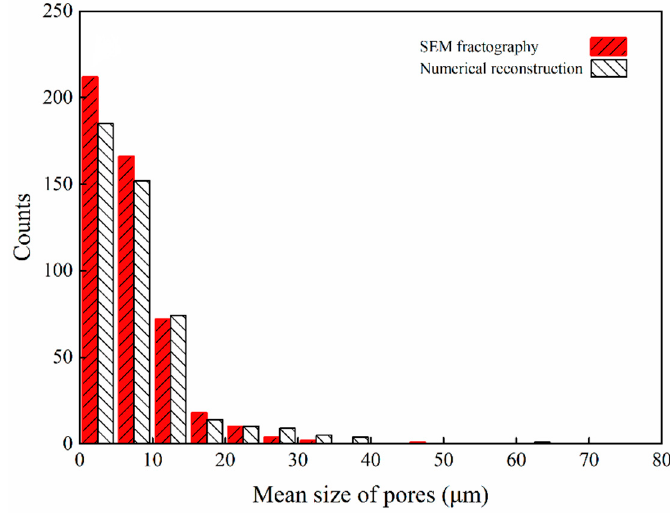
Figure A2. The pore size measurement procedure by ImageJ software.